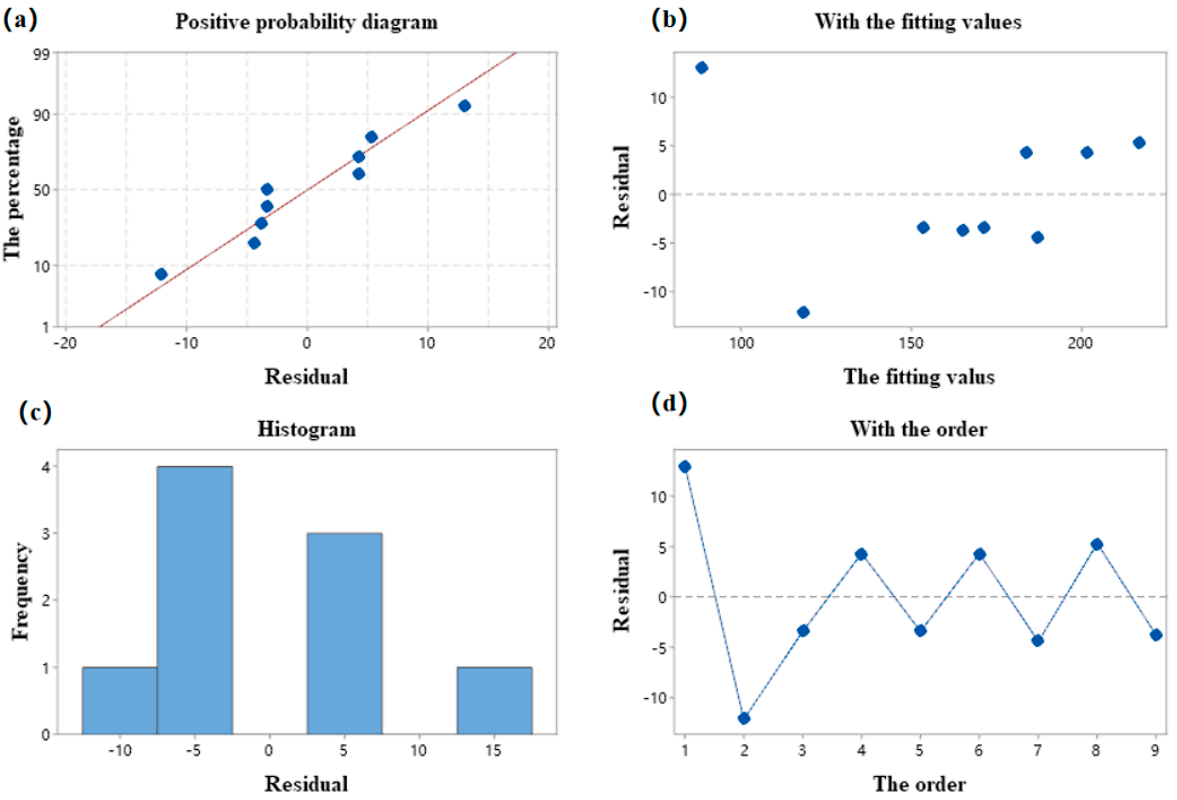
Figure 16. ( a ) Normal probability plot. ( b ) Plot with fitted values. ( c ) Plot with fitted values. ( d ) Plot with fitted values.